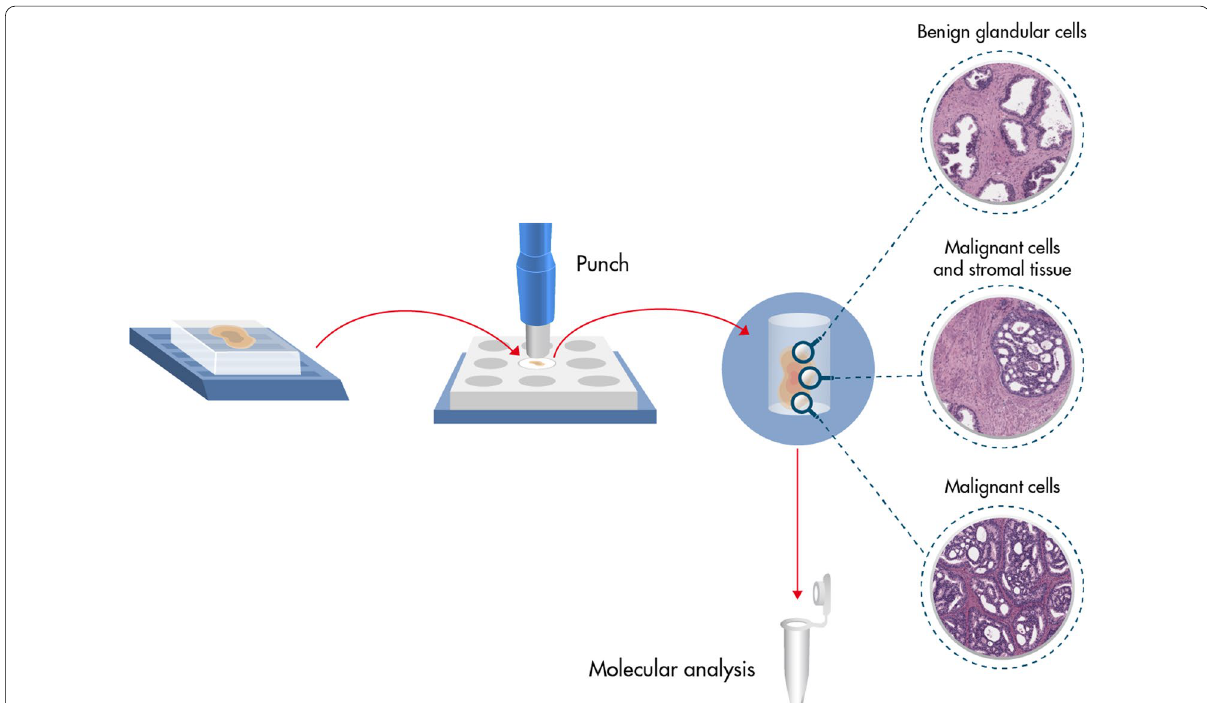
Table 1 Protocol to deparaffinize the sections of FFPE tissue